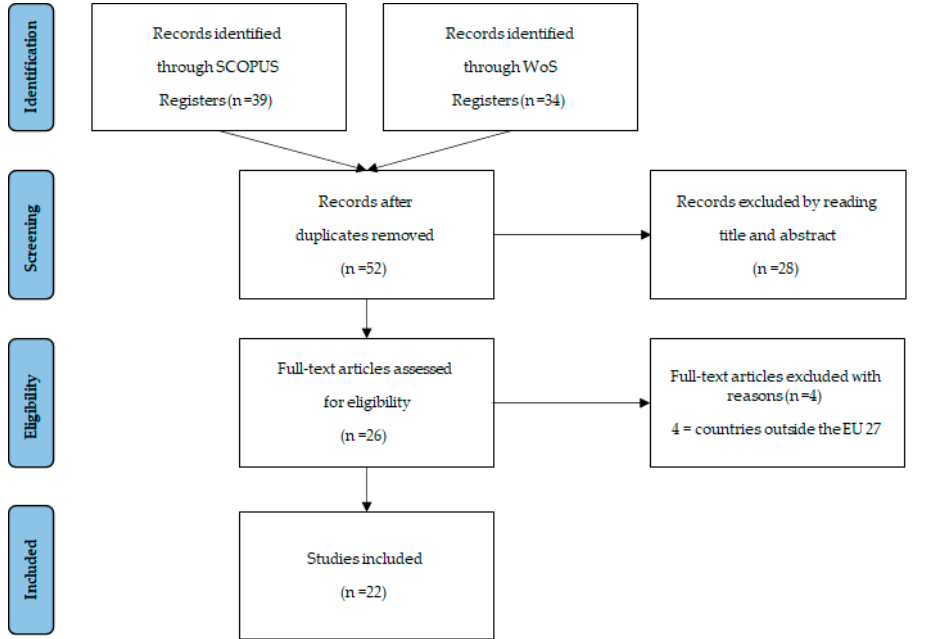
Figure 4. PRISMA flowchart of the systematic literature review.